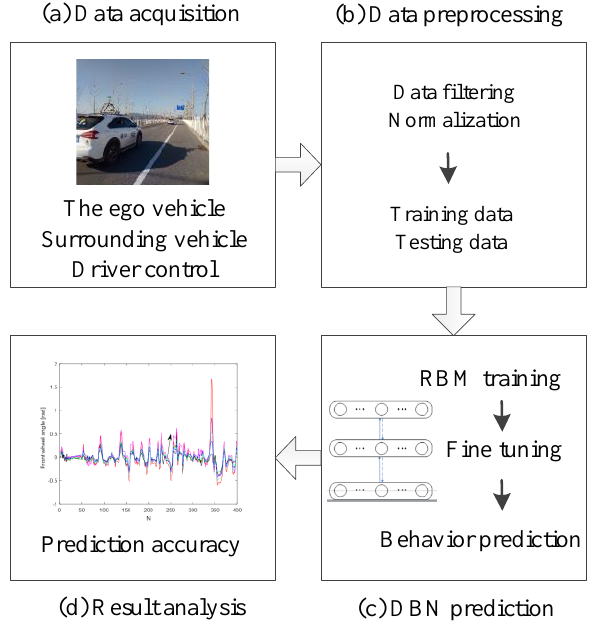
Figure 1. Proposed driving behavior prediction